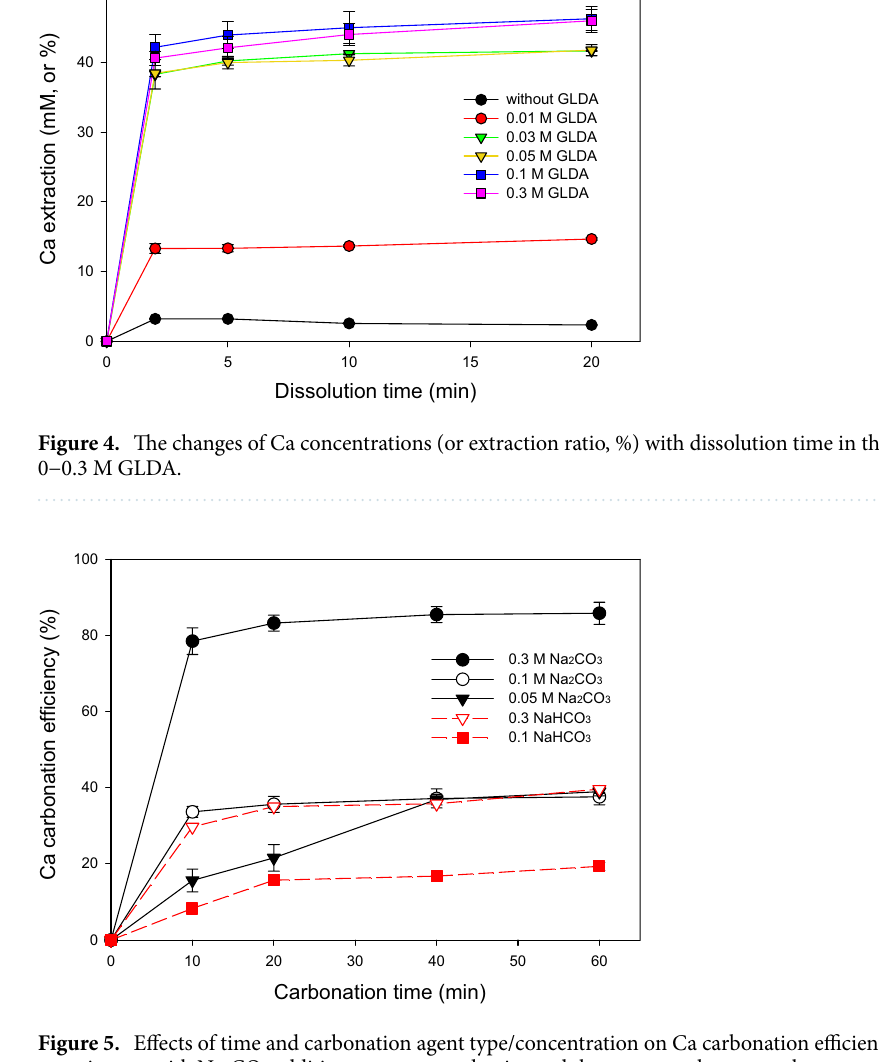
Figure 5. Effects of time and carbonation agent type/concentration on Ca carbonation efficiency. Carbonation experiments with Na 2 CO 3 addition were repeated twice and the average values were